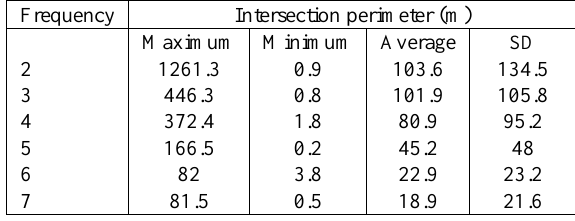
Table2. Evaluation of the perimeter index in the intersection areas proposed by citizens.